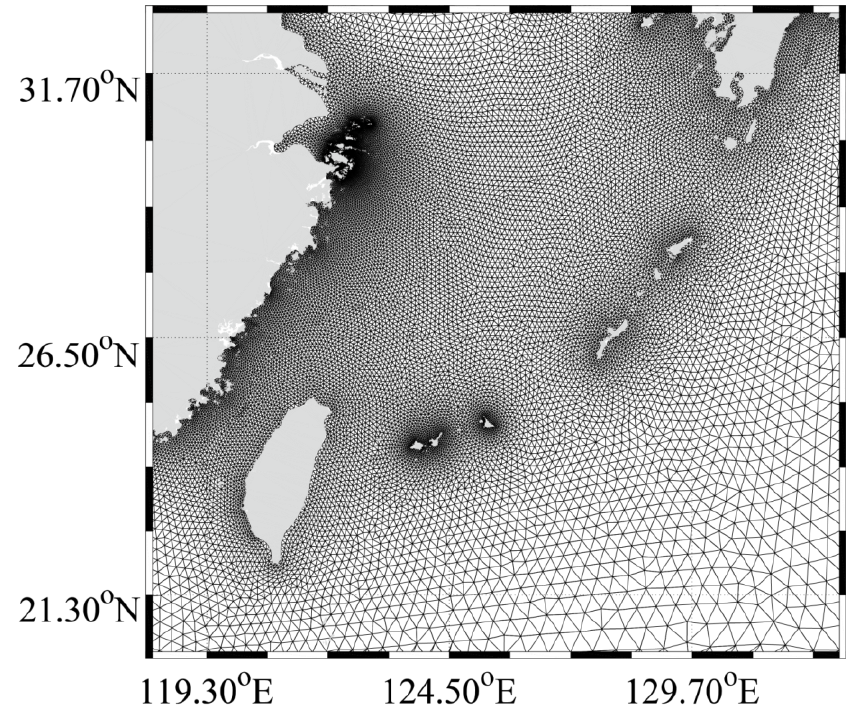
Figure 2. Map of the unstructured grids used in the SWAN and FVCOM simulations.